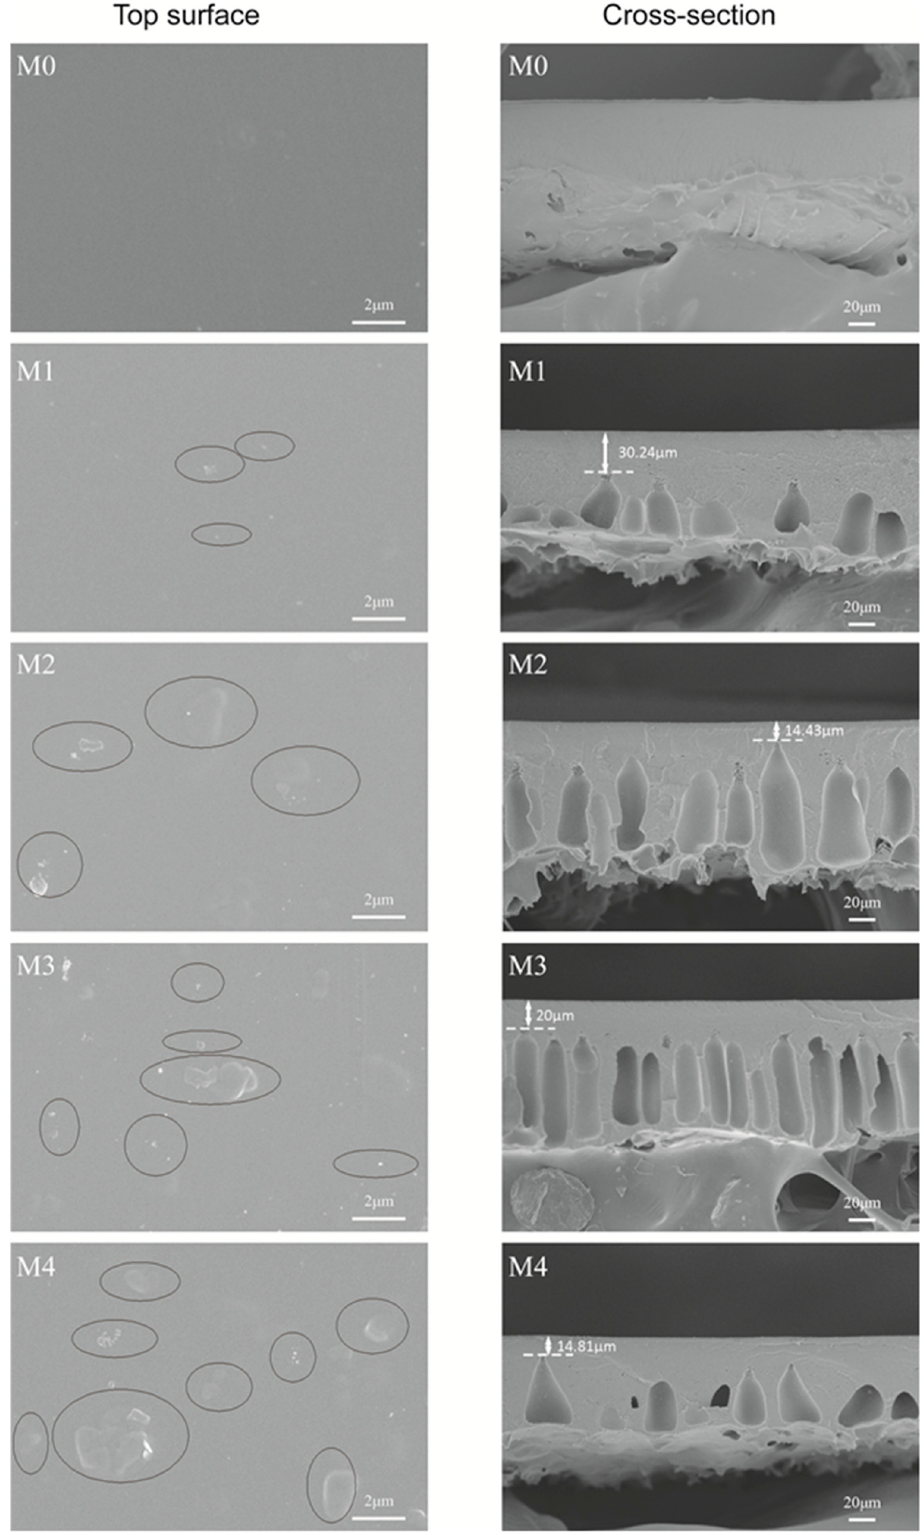
Figure 4. SEM surface and cross-sectional images of PES and PES/MoS 2 membranes.